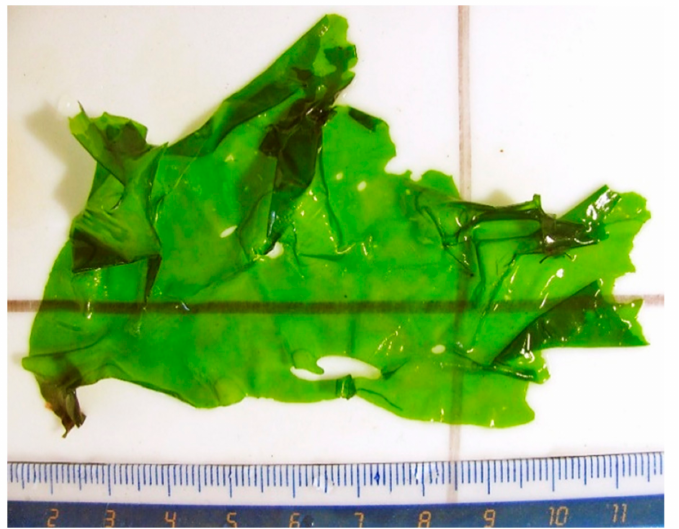
Figure 1. Ulva sp. specimen collected from Mondego River estuary in January 2020.